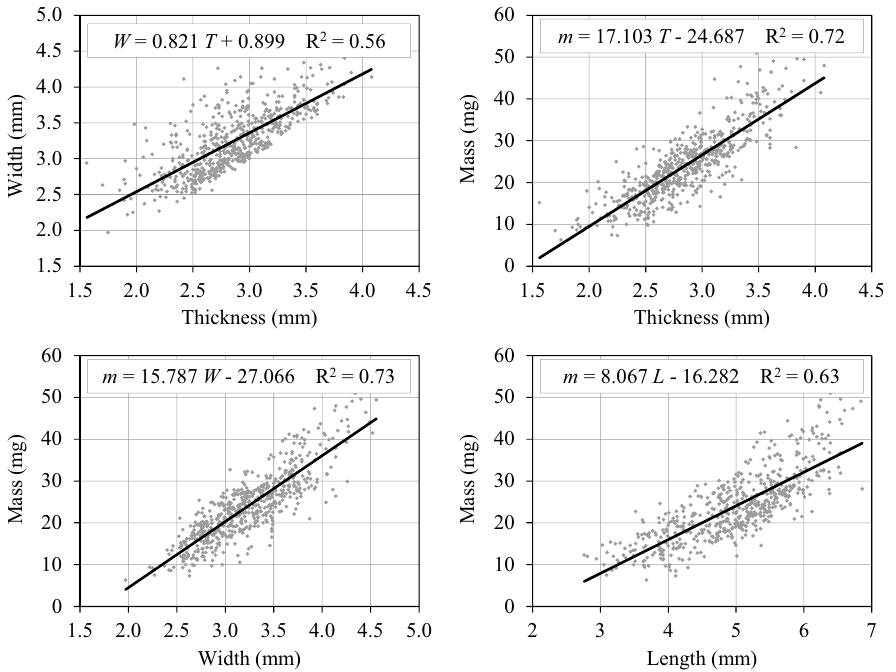
Figure 1. Relationships between the physical properties of seeds.